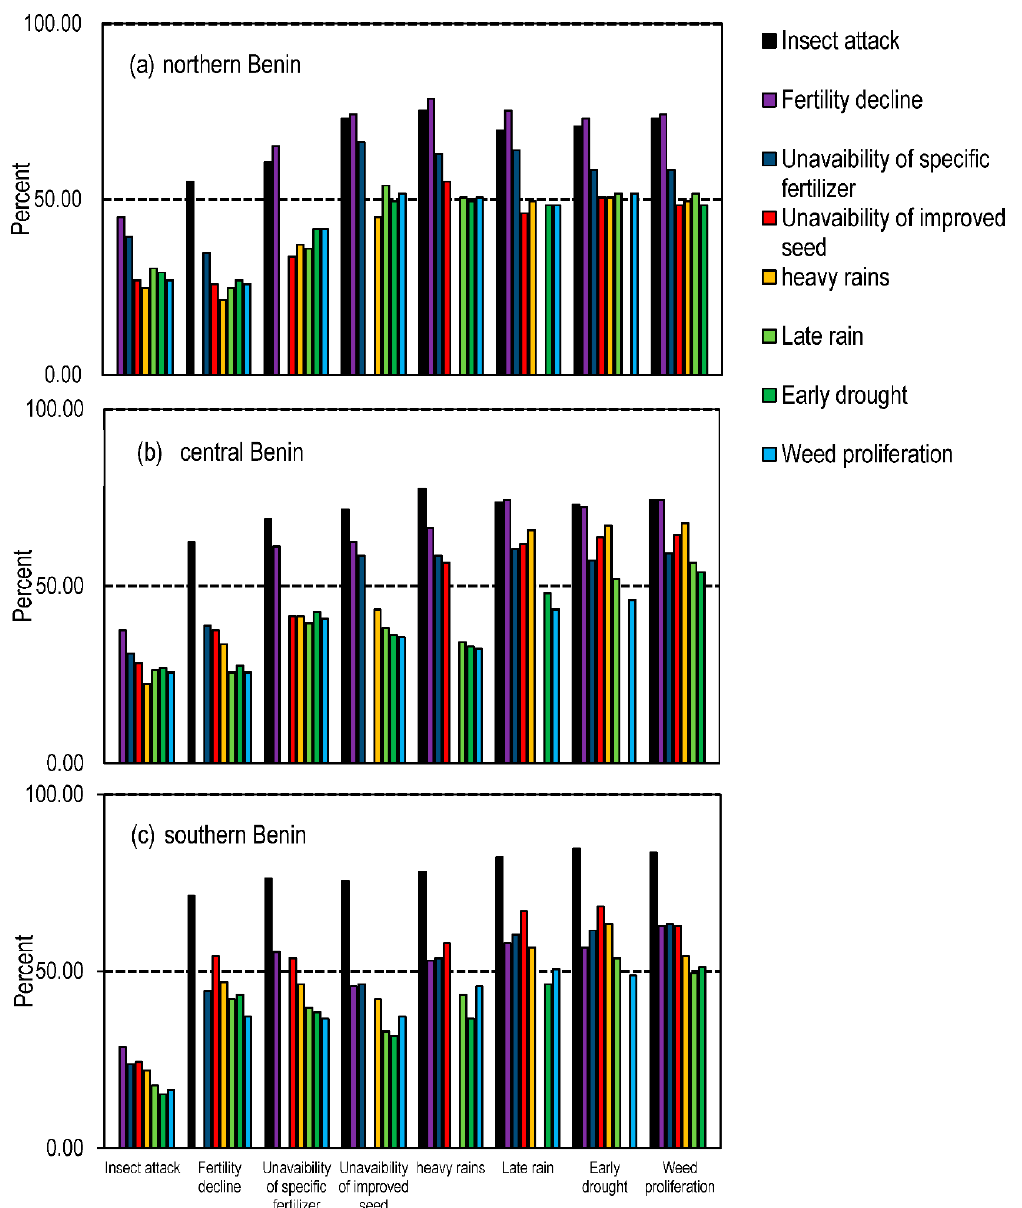
Figure 4. Pairwise comparison matrix of items of cowpea cropping system and environment responsible for poor perfor- mance from northern to southern Benin: ( a ) Northern Benin, ( b ) Central Benin, ( c ) Southern